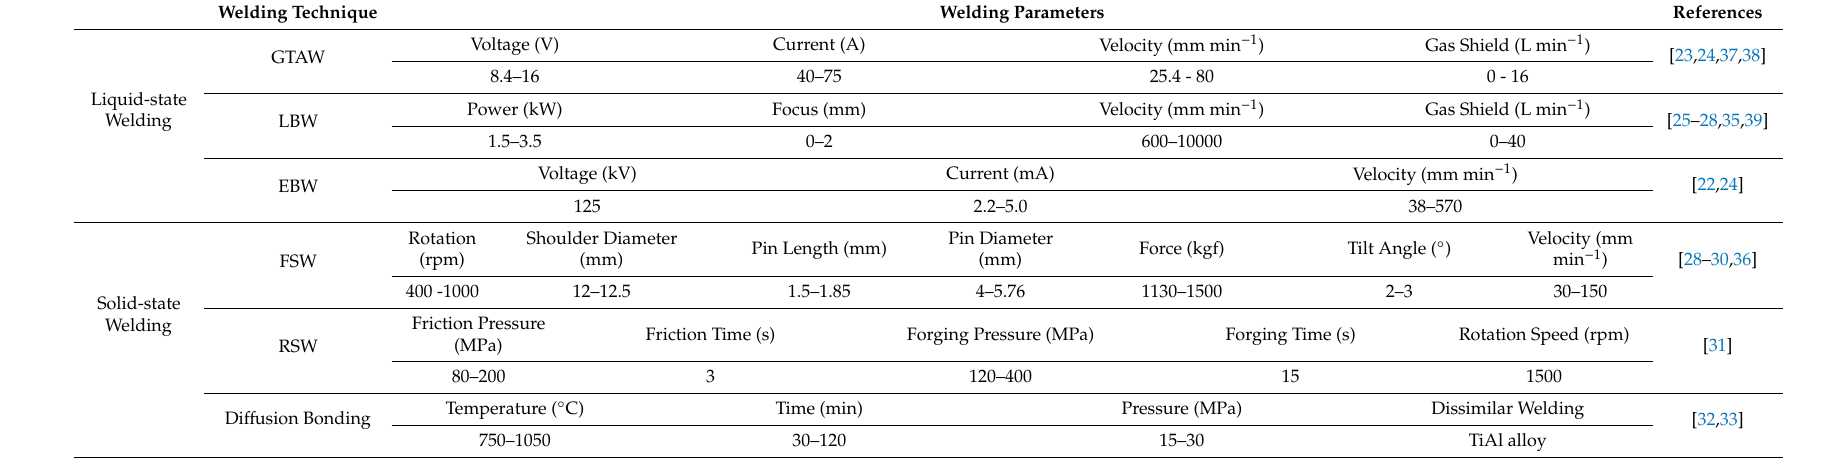
Table 1. Welding parameters and techniques reported for high entropy alloys